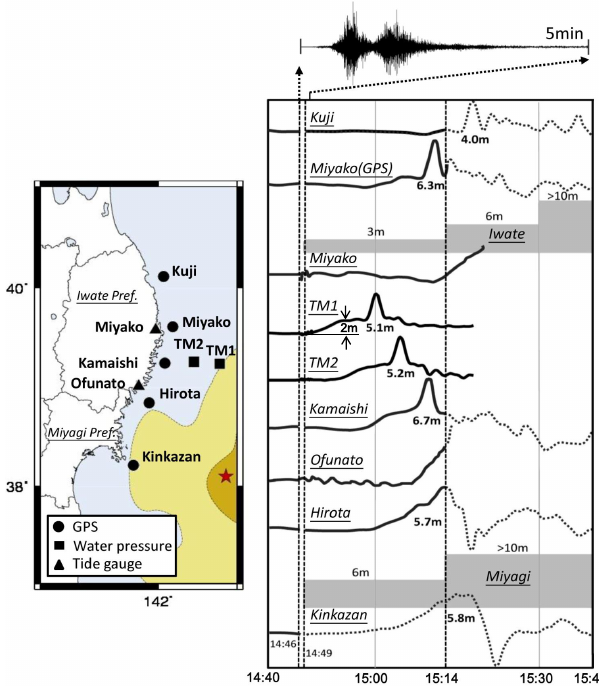
Fig. 6. Tsunami waveforms recorded at ocean-bottom pressure gauges (TM1 and TM2), five GPS buoy wave meters and two tidal gauge stations. The solid lines show the time ranges during which the data were monitored in real time, and the dashed lines show those for which data were stored at onshore stations and recov- ered later due to the blackout. At the top, the vertical strong-motion record from station HTKD of the National Institute of Disaster Mit- igation and Science (NIED) is shown. HTKD was located near the tide gauge station Ofunato (solid triangle). 5min after the origin time of the 2011 Great East Japan Earthquake. The gray boxes show the forecasted tsunami heights for Iwate (upper) and Miyako (lower) prefectures, issued by the first warning at 14:49LT, the sec- ond at 15:14LT, and the third at 15:30LT. The major tsunami waves struck the interviewed towns at approximately 15:20–15:30LT. The 5m and 30m fault slip contours for the Great East Japan Earthquake are also shown (Lee et al., 2011). The epicenter of the main shock is indicated by the